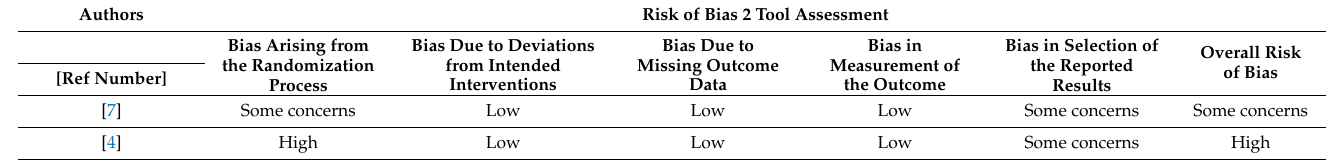
Table A2. Quality scores for the eligibility studies for mean length of postoperative wound.